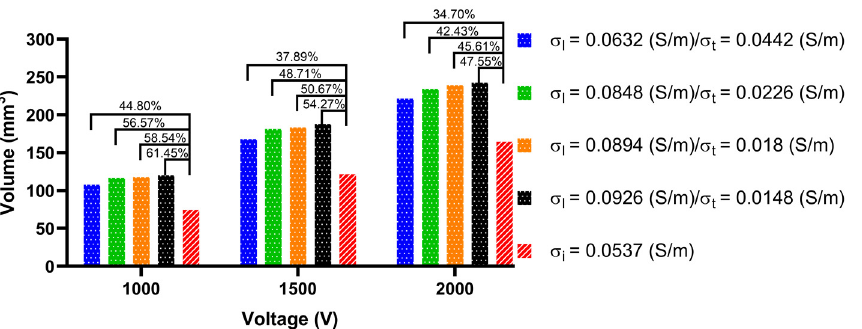
Figure 15. The statistical results of the size of the ablation volume generated by different ACs and ICs under the condition of different PFA amplitudes at ablation target 1, where the numbers between the top of the bars represent the absolute percentage difference in the size of the ablation volume between AC and IC in the four electrical conductivity groups, respectively.